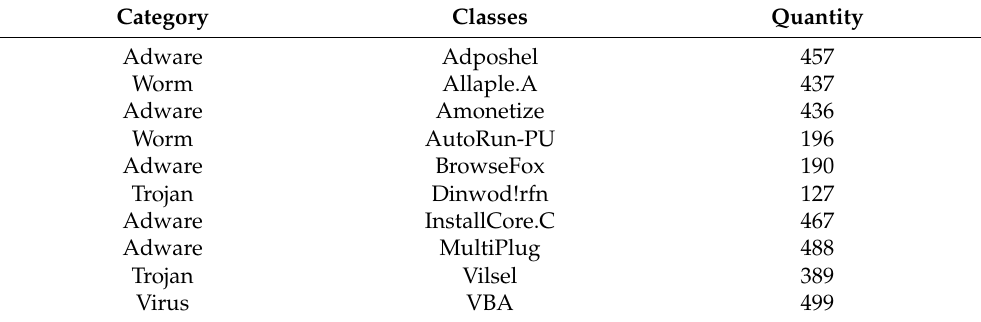
Table 2. Memory dump dataset consisting of ten classes of malicious software and one class of benign